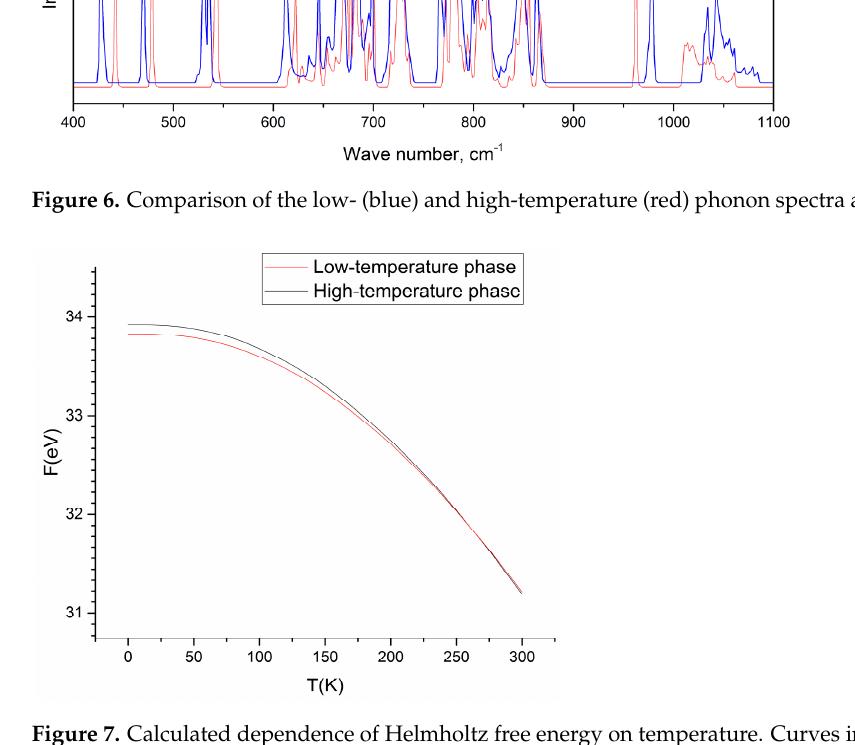
Figure 7. Calculated dependence of Helmholtz free energy on temperature. Curves intersect at 263 K, which is near the phase transition temperature reported in the literature (258.15 K).